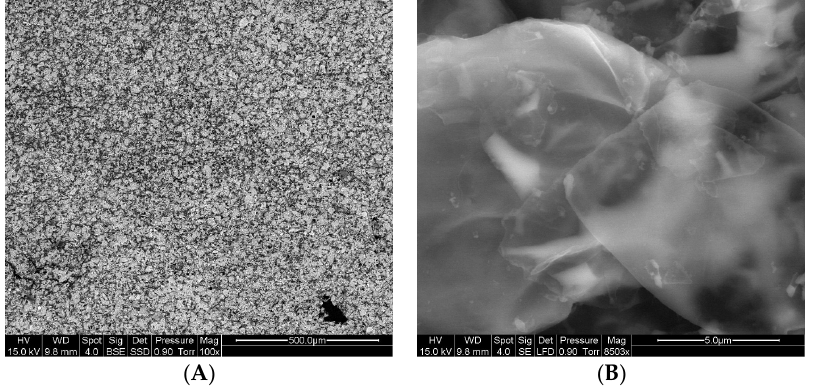
Figure 16. Scanning electron microscope (SEM) observations of 5A20 film residue at two different scales. ( A ) Low magnification; ( B ) High magnification.